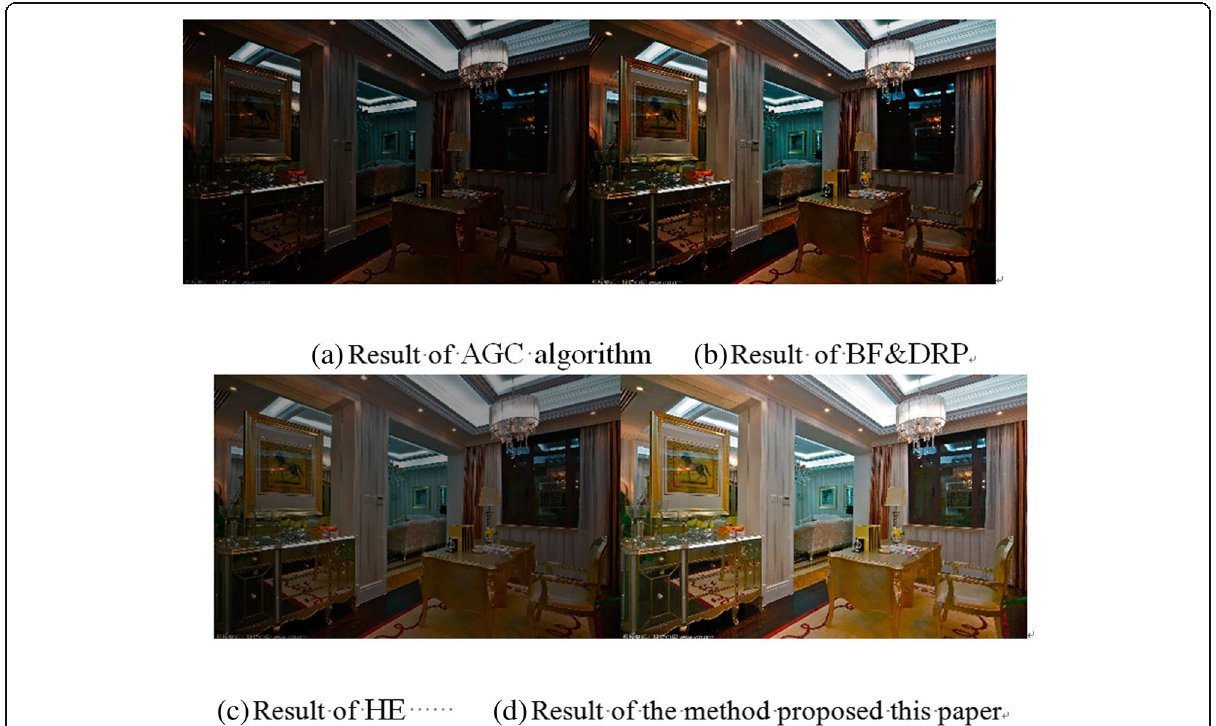
Fig. 7 a – d Comparison of the processing results of several algorithms for the indoor